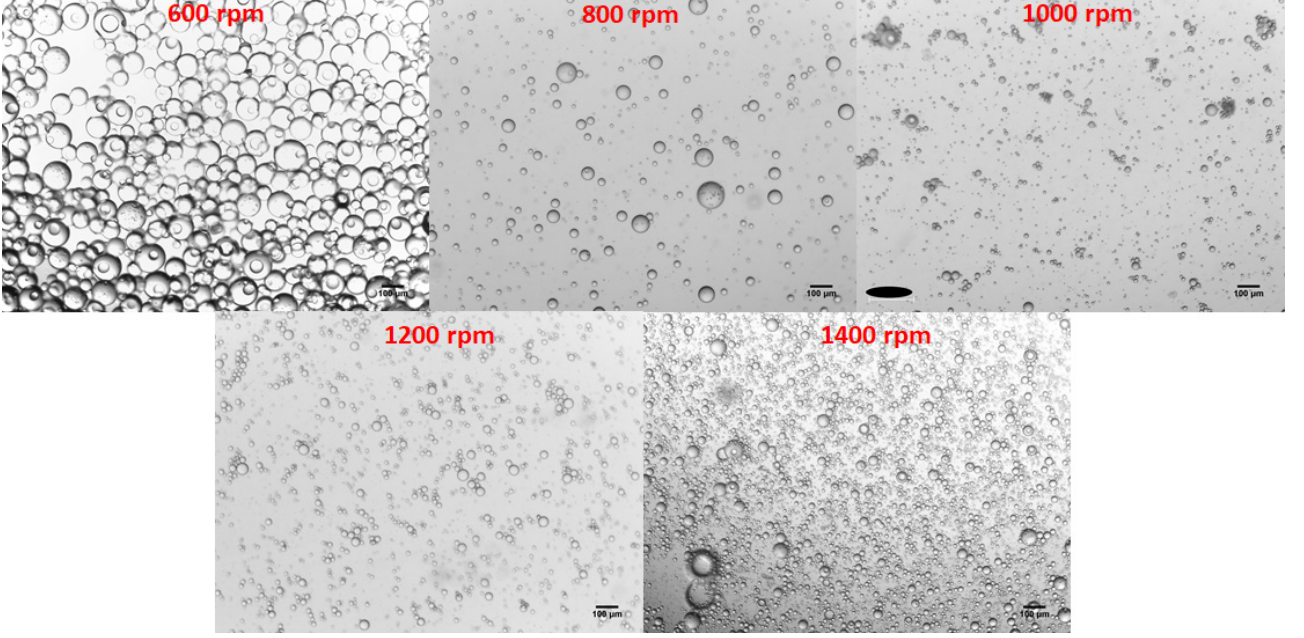
Figure 6. Optical microscope (Leica Microsystem DM300) images of particles sizes produced by varying the stirring speed during the emulsion polymerization process.